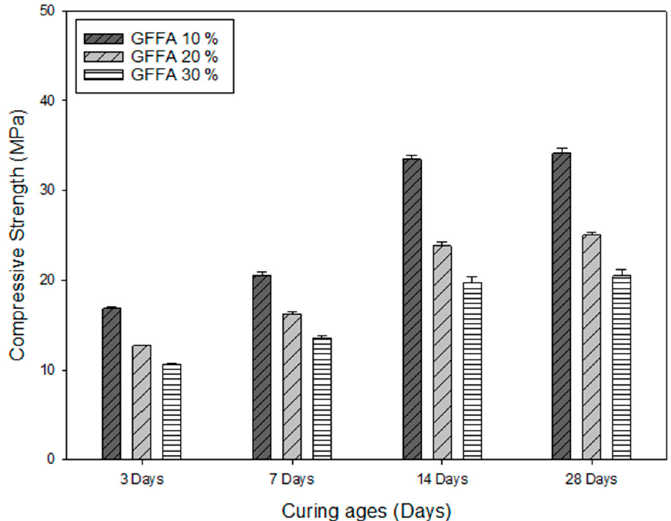
Figure 1. The compressive strength of different percentages of the grate firing fly ash (GFFA) in the alkali-activated material (AAM) bricks.